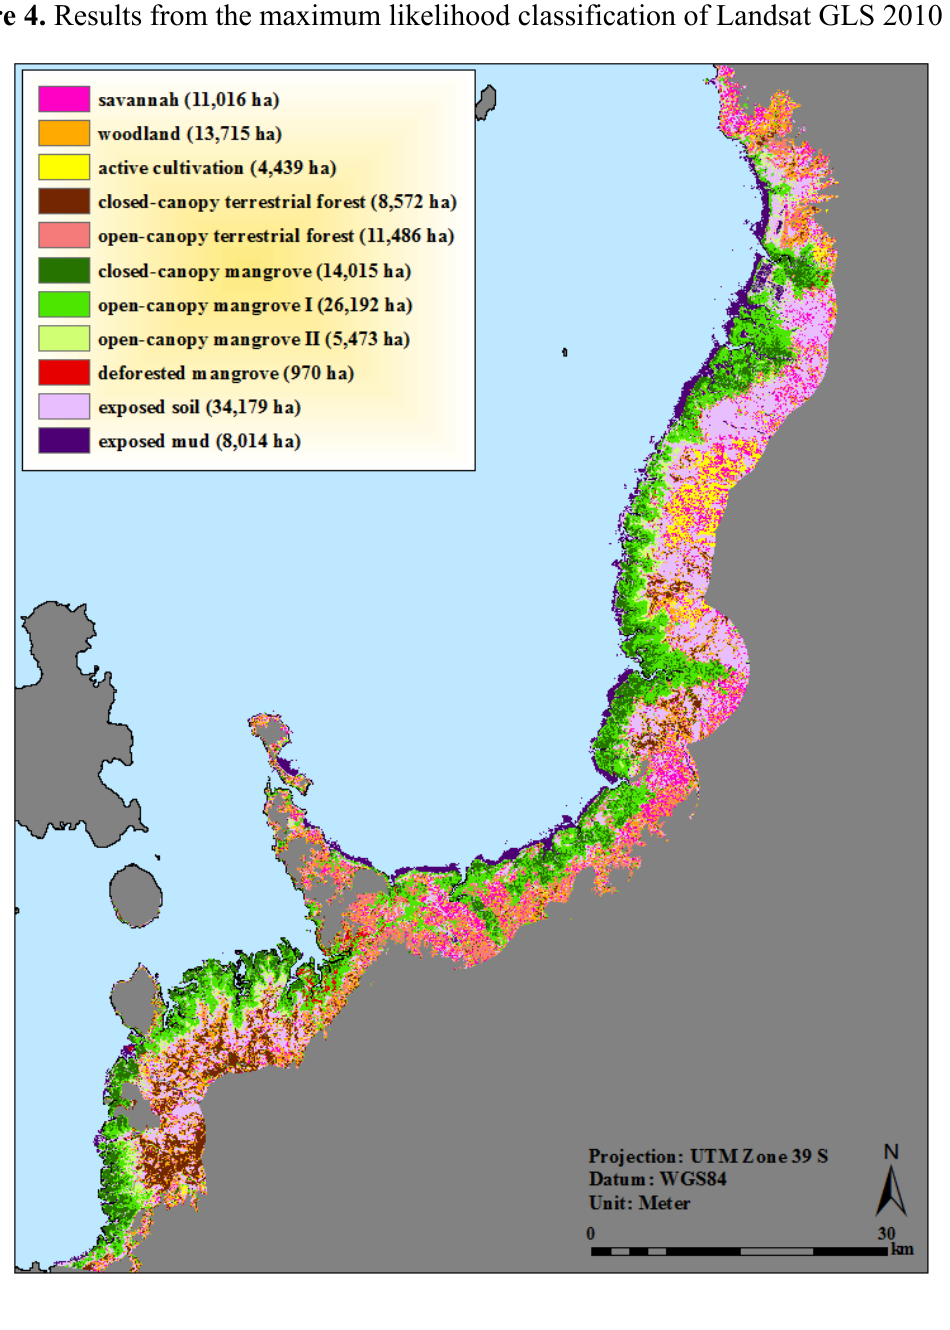
Figure 4. Results from the maximum likelihood classification of Landsat GLS 2010